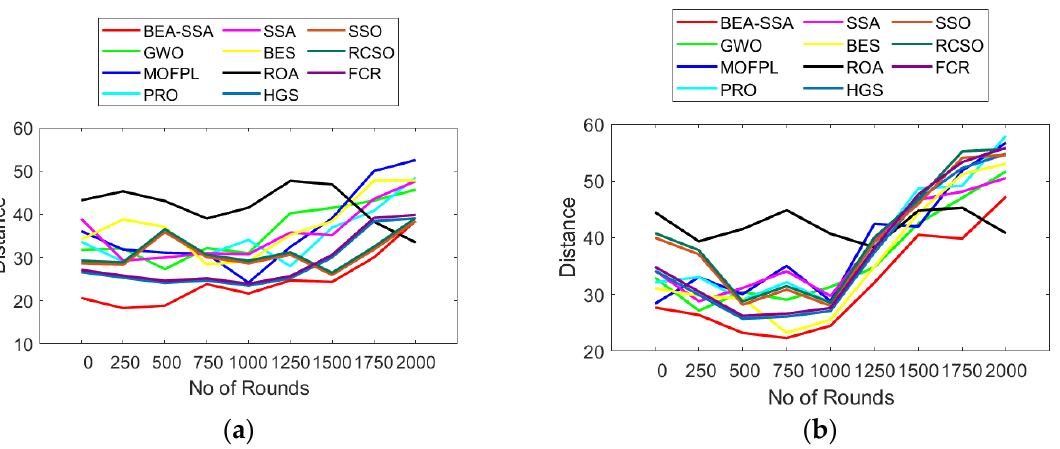
Figure 5. Distance analysis using BEA ‐ SSA compared with other models [20–22,26] for node counts of ( a ) 100 and ( b ) 200. Table 4. Statistical Analysis on BEA-SSA compared with other models for 100 nodes.